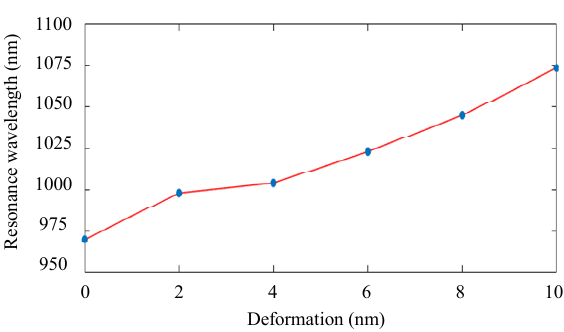
Fig. 4 Transmission spectra for different deformations d of the res3.